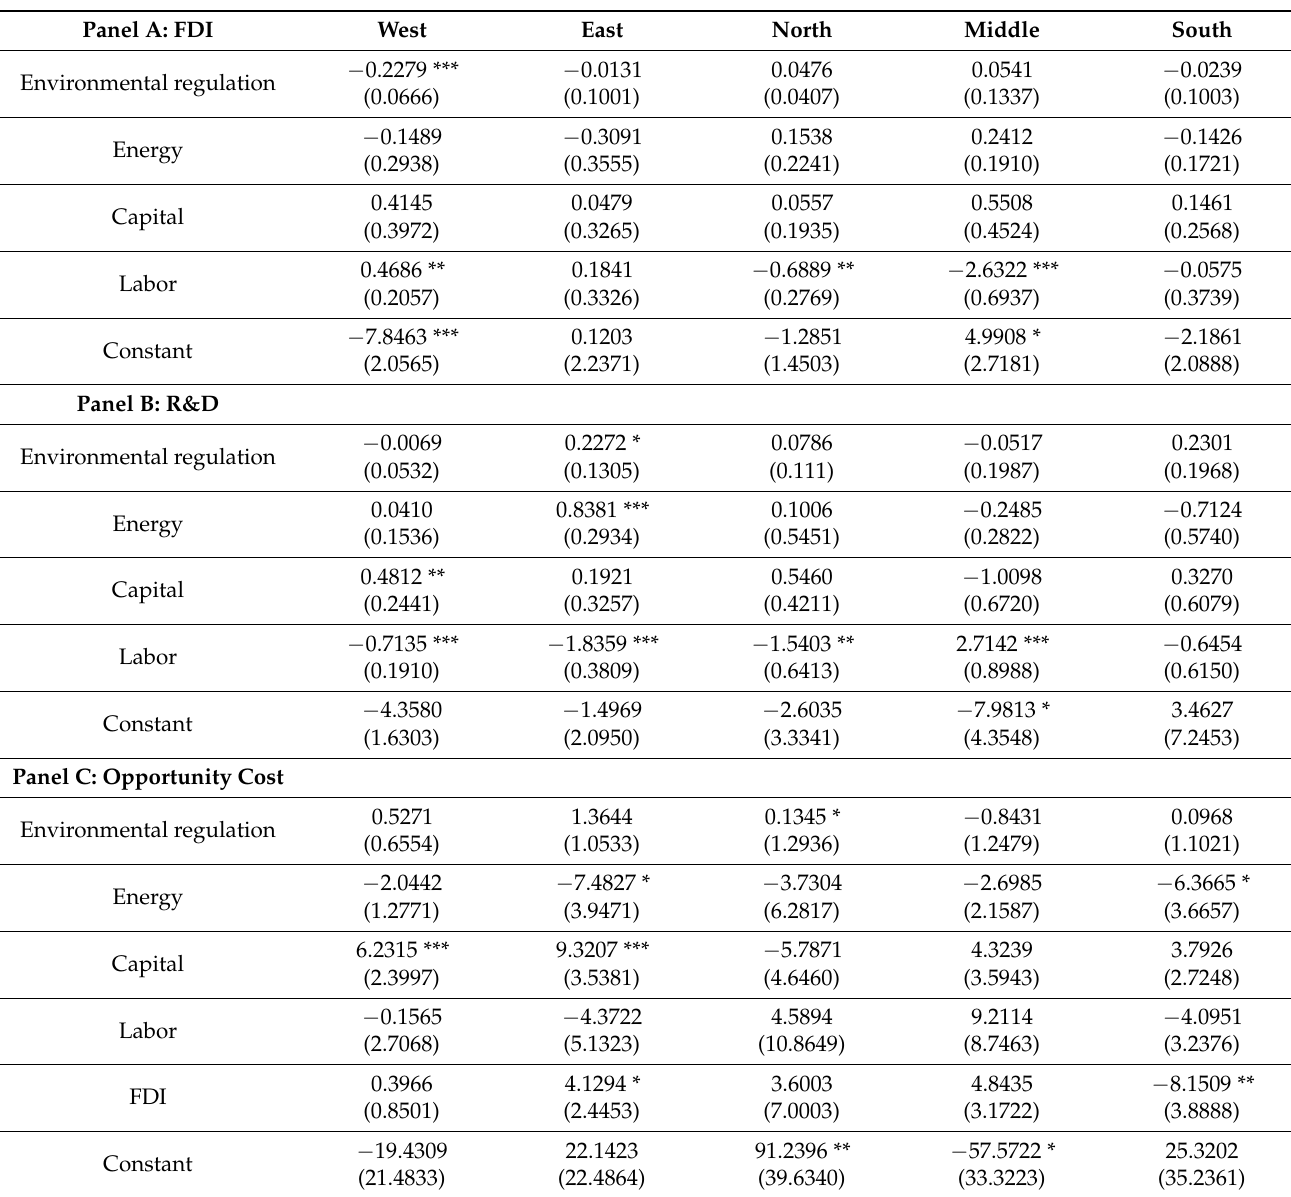
Table 4. Heterogeneous effects by